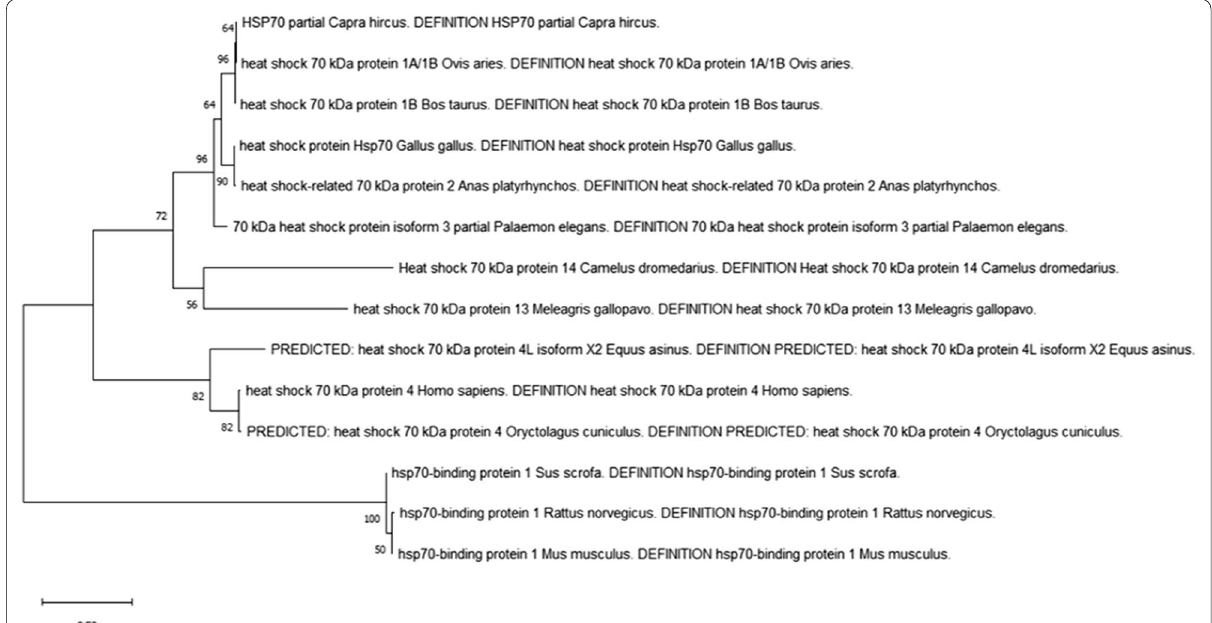
Fig. 1 The dendrogram of evolutionary relationships among the selected farm animals, humans, and elegans. The evolutionary relationship was built using the Maximum Likelihood method and Dayhoff matrix-based model. A discrete Gamma distribution was used to model the evolutionary rate differences among sites [5 categories ( G , parameter 4.8621)]. The tree was drawn to scale, with branch lengths measured in the number of + = substitutions per